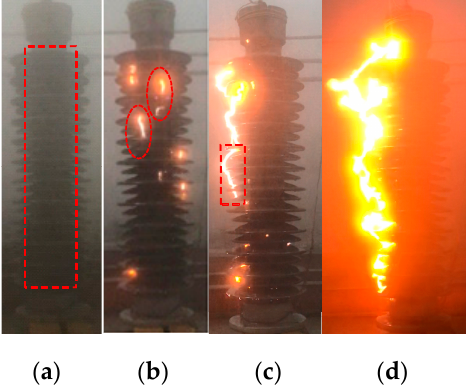
Figure 13. Flashover process of post insulator.